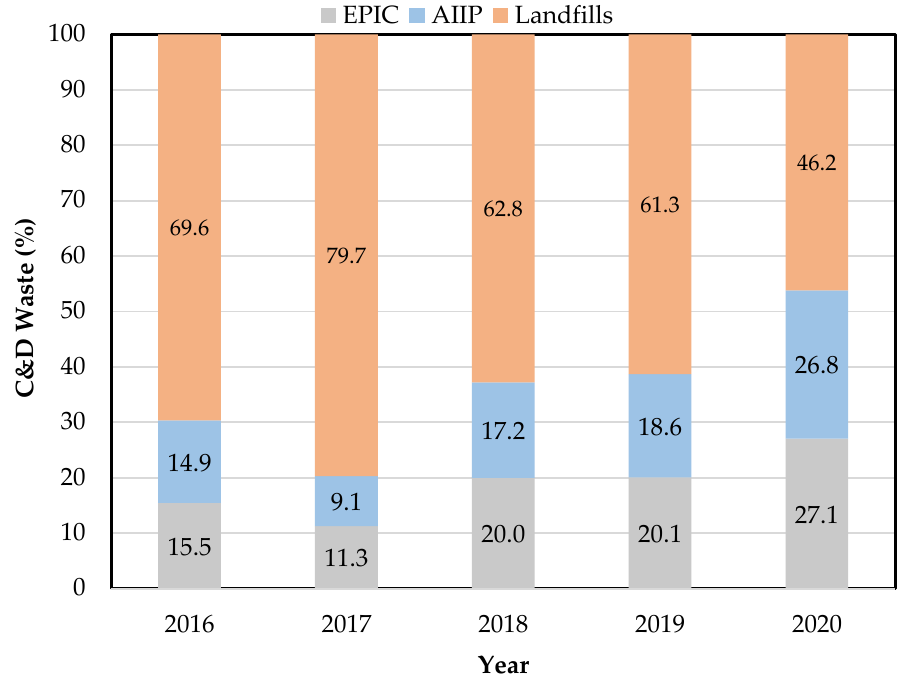
Figure 7. Percentages of C&D waste handled by different facilities.